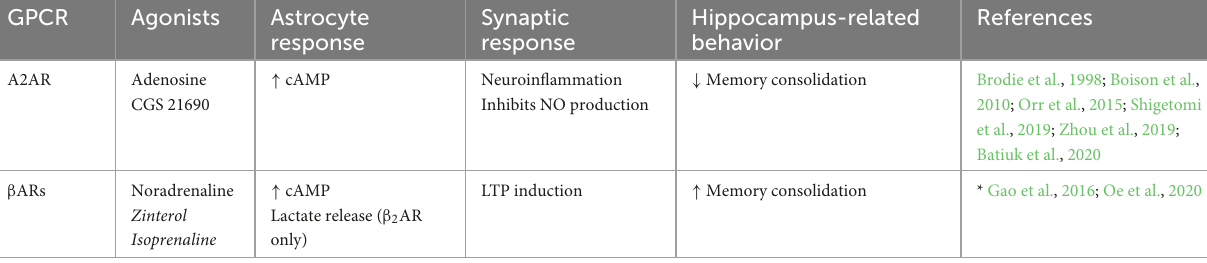
TABLE 2 Endogenous Gs-GPCRs in adult mouse hippocampus: Synaptic and behavioral effects.